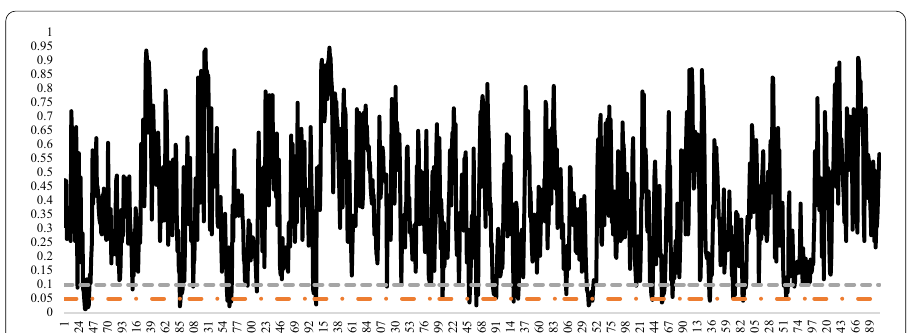
Fig. 20 The evolving p values of the GS test statistic checked for the Bitcoin (BTC) in 50-day window length